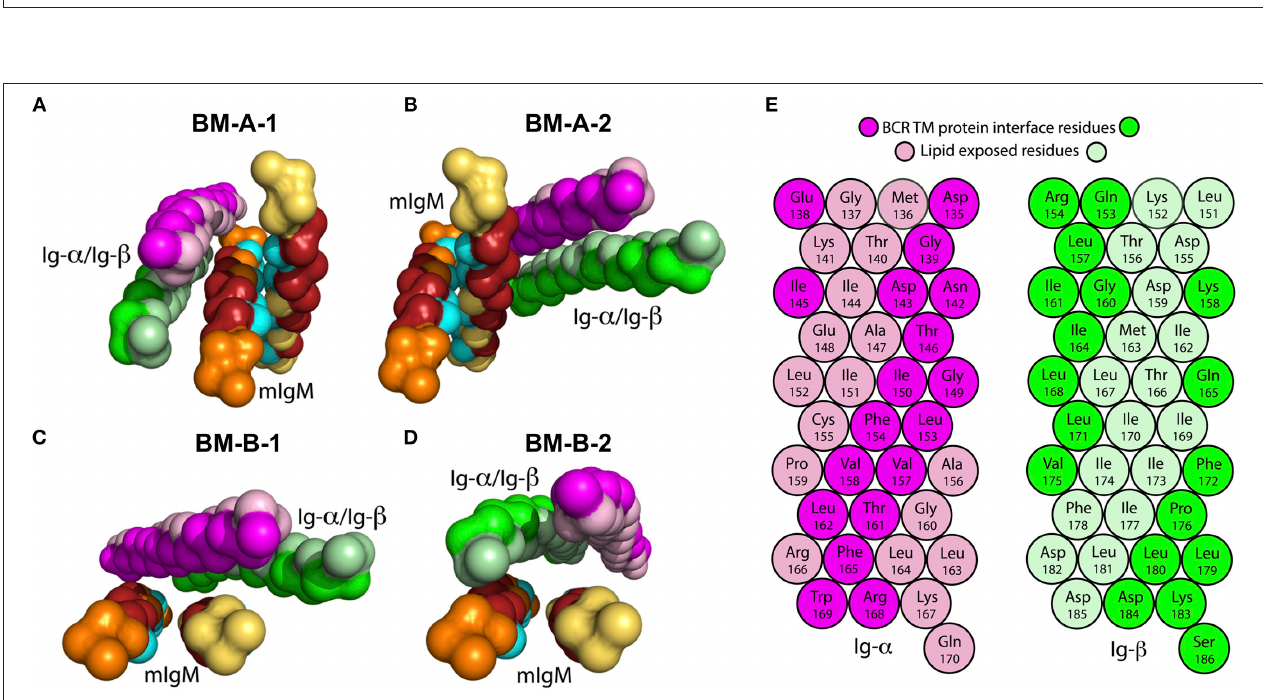
FIGURE 5 | (A) Contact map for amino acids within the Ig- α /Ig- β dimer in the BM- α configuration. Residues in close proximity are labeled. (B) Representative structure of the Ig- α /Ig- β dimer (BM- α conformer) in cartoon representation. Ig- α is colored magenta, Ig- β green. Charged residues that are involved in salt-bridge formation are additionally shown as sticks and highlighted in the insets.